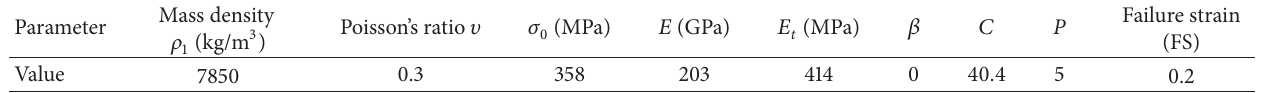
Table 1: Material parameters of the steel tube.